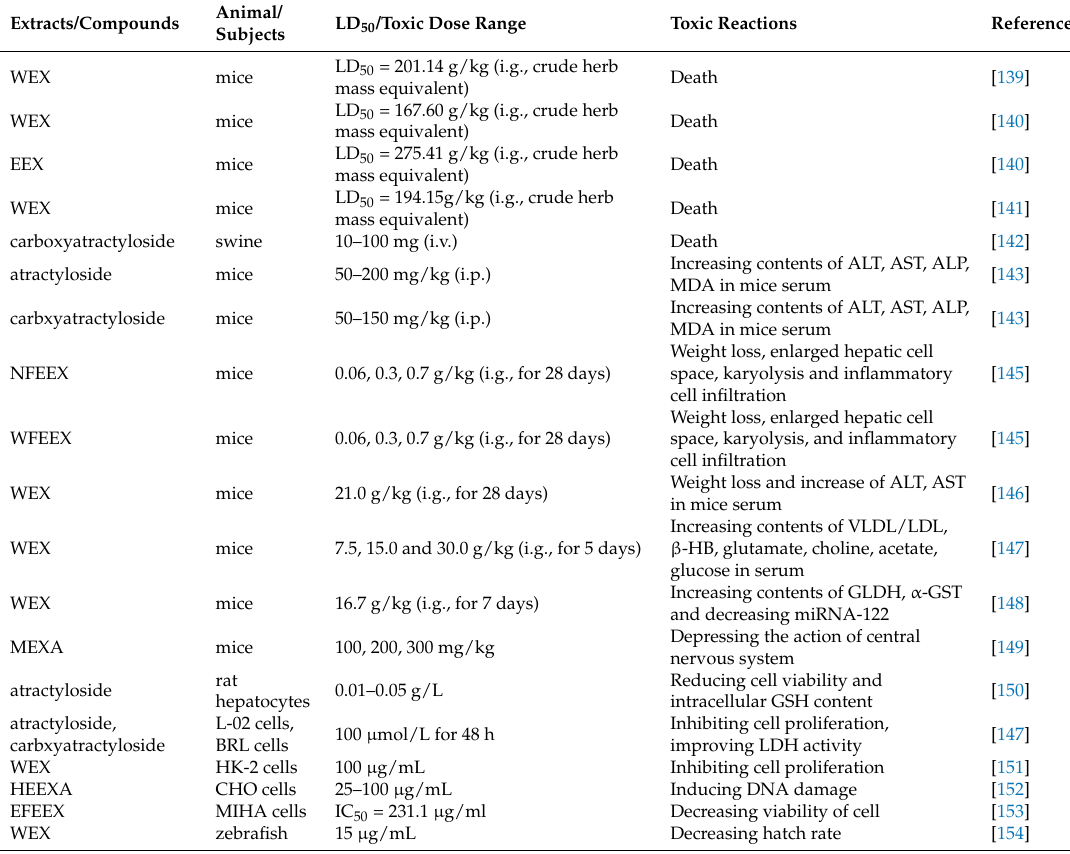
Table 4. Toxicities and side effects of X.